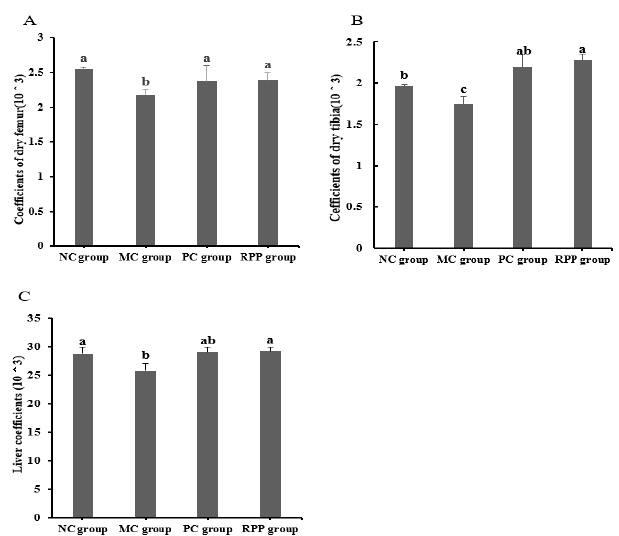
Figure 6. E ff ect of RPP on organ coe ffi cients in rats. Organ coe ffi cients of( A ) femur, ( B ) tibia, and ( C ) liver in each group were determined. Groups with di ff erent letters are significantly di ff erent ( p <